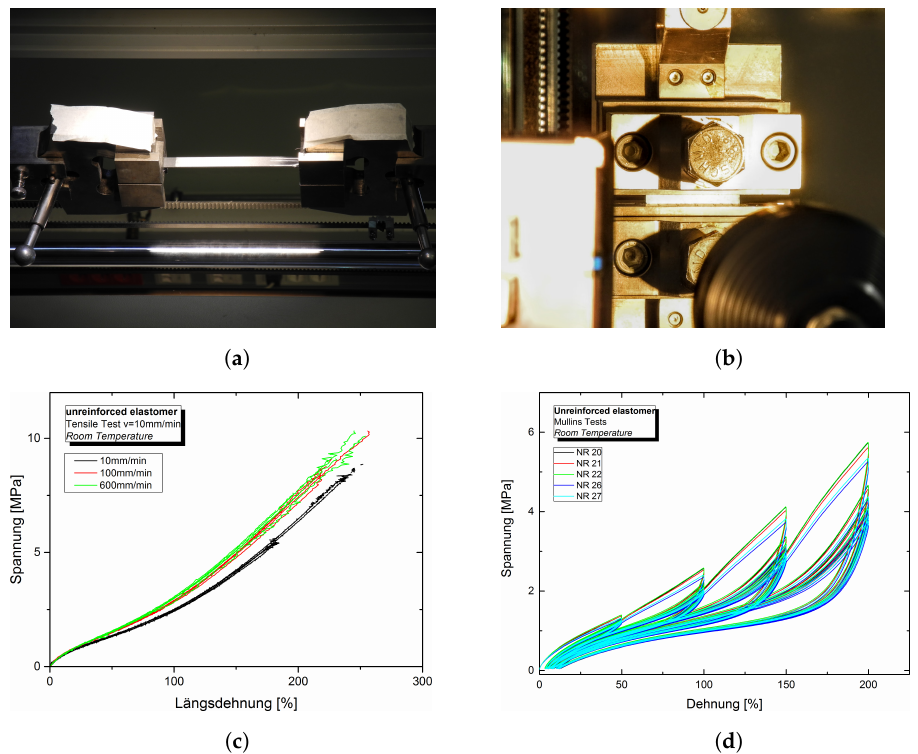
Figure 4. ( a ) Uniaxial tension test setup. ( b ) Plane shear test setup. ( c ) Force–displacement curves for uniaxial tension test. ( d ) Force–displacement curves for cyclic